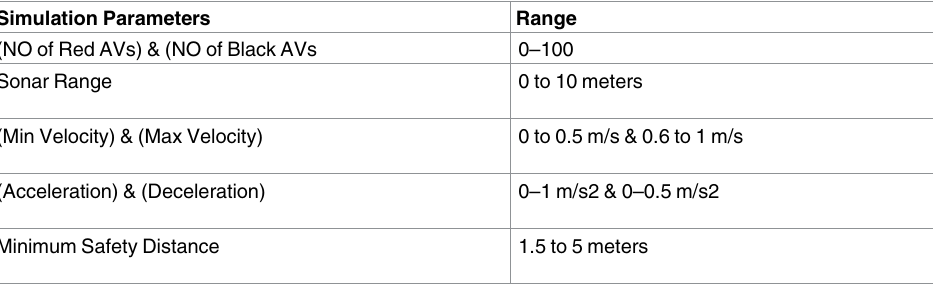
Table 1. Simulation parameters and their designated